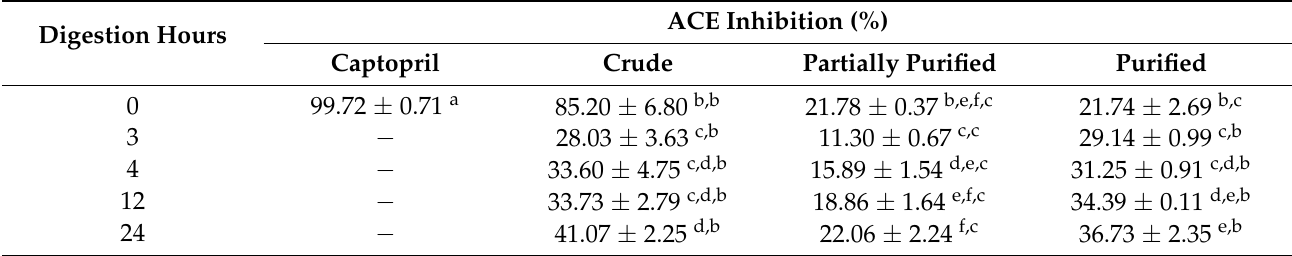
Table 2. ACE inhibition (%) of crude, partially purified and purified protein extracts at 0, 3, 4, 12, and 24 h of digestion *.